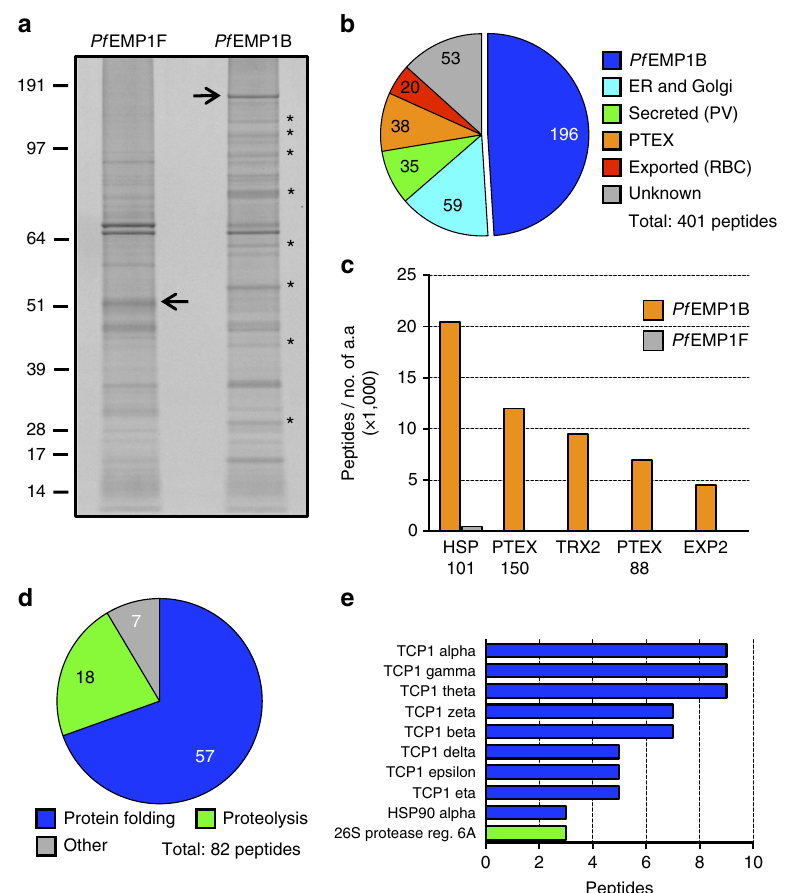
Figure 3 | Global analysis of Pf EMP1B-interacting proteins. ( a ) Silver-stained SDS-PAGE of material eluted from IPs of crosslinked Pf EMP1F and Pf EMP1B parasite lysates. Examples of protein bands enriched in the Pf EMP1B eluate are marked with asterisks. Full-length Pf EMP1F and Pf EMP1B are indicated with arrows. Molecular masses are shown in kDa. ( b ) Peptides identified by tandem mass spectrometry in Pf EMP1B IPs sorted according to function or known localization of the parent proteins. ( c ) Relative abundance of co-precipitated PTEX components with Pf EMP1B as determined by dividing the number of peptides identified by the number of amino acids (a.a.) of the individual PTEX proteins. ( d ) Human peptide matches identified in Pf EMP1B IPs sorted according to the functions of the parent proteins. ( e ) The top 10 human proteins (by fold enrichment) identified in Pf EMP1B IPs. ( b – e ) Peptide numbers are based on averages from two independent experiments. All identified proteins are listed in Supplementary Tables 1 and EPIC (Fig. 5b, black arrow), suggesting that components of EPIC may shuttle between complexes.